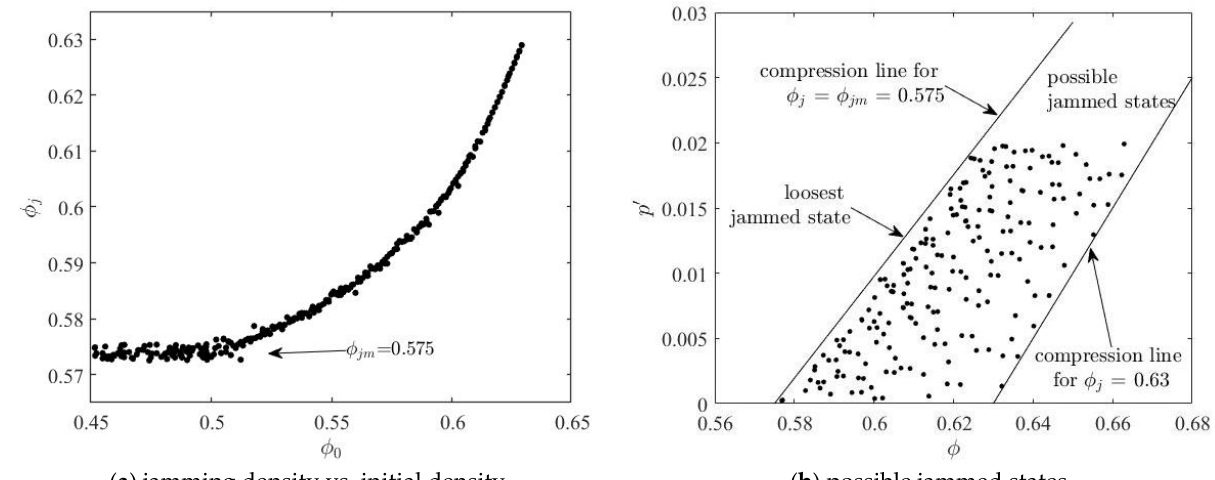
Figure 2. Loosest jammed states and possible jammed